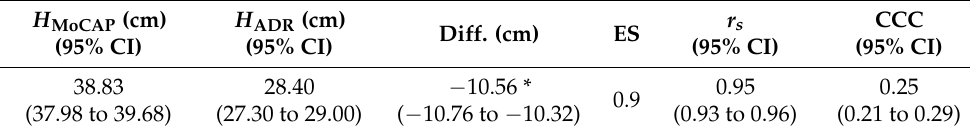
Table 1. Mean, the difference of means, significant differences between means and Spearman correlations, and agreement of ADR jumping and